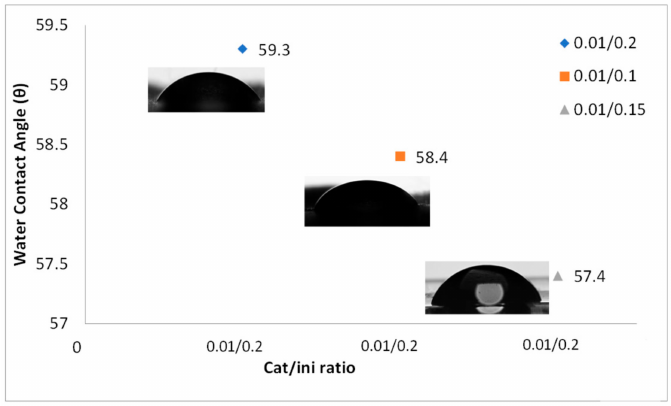
Figure 8. Contact angle of PLA-co-PPGDGE by varying cat/ini ratio. Copolymer 80/20 ( L